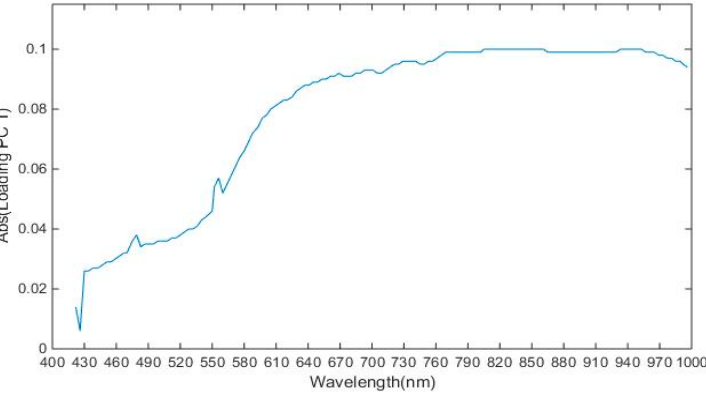
Figure 7. Absolute loadings for first PC.